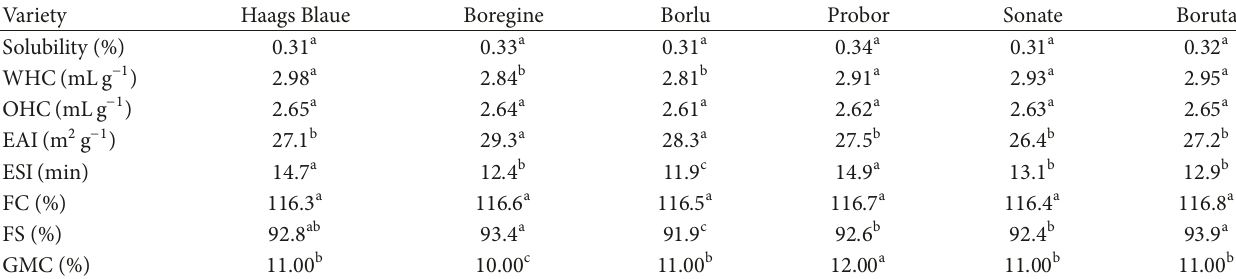
Table 2: Functional properties of protein isolates obtained from seeds of varieties of Lupinus angustifolius cultivated in Mexico. Variety Haags Blaue Boregine